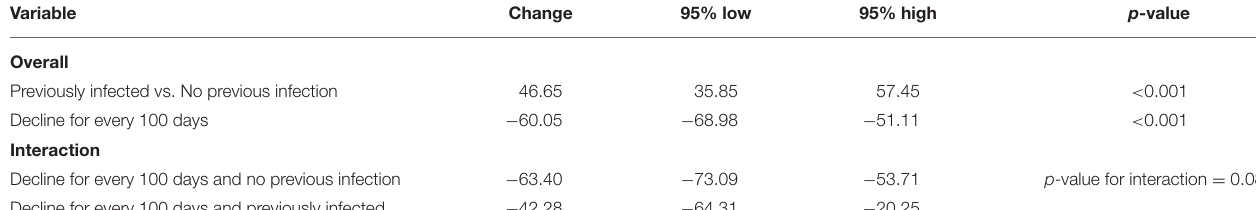
TABLE 3 | Change in IgG levels (in BAU/ml) in adjusted multiple linear models for those who received 2 doses of BNT162b2. Variable